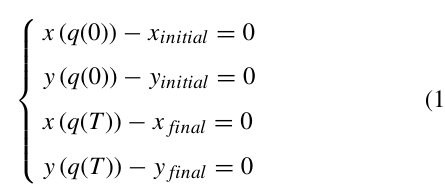
systematic method used to check the penetration value of the box into the body in each iteration of the opti- mization process. This process is described as brief as bellow.